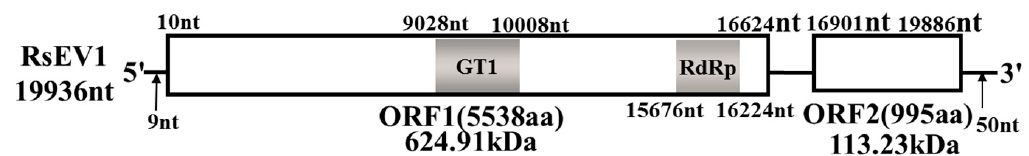
Figure 1. Genomic organization of a novel dsRNA endornavirus, Rhizoctonia solani endornavirus 1 (RsEV1) in Rhizoctonia solani AG-1 IA. The open reading frame (ORF) and the untranslated regions (UTRs) are indicated by a rectangle and single line, respectively. The shadowing parts indicate the glycosyltransferase 1 (GT1) and RNA-dependent RNA polymerase (RdRp) conserved domains. The corresponding nucleotides in the genome are given above the rectangle, and the amino acid numbers and the molecular masses of the proteins are shown below the rectangle.